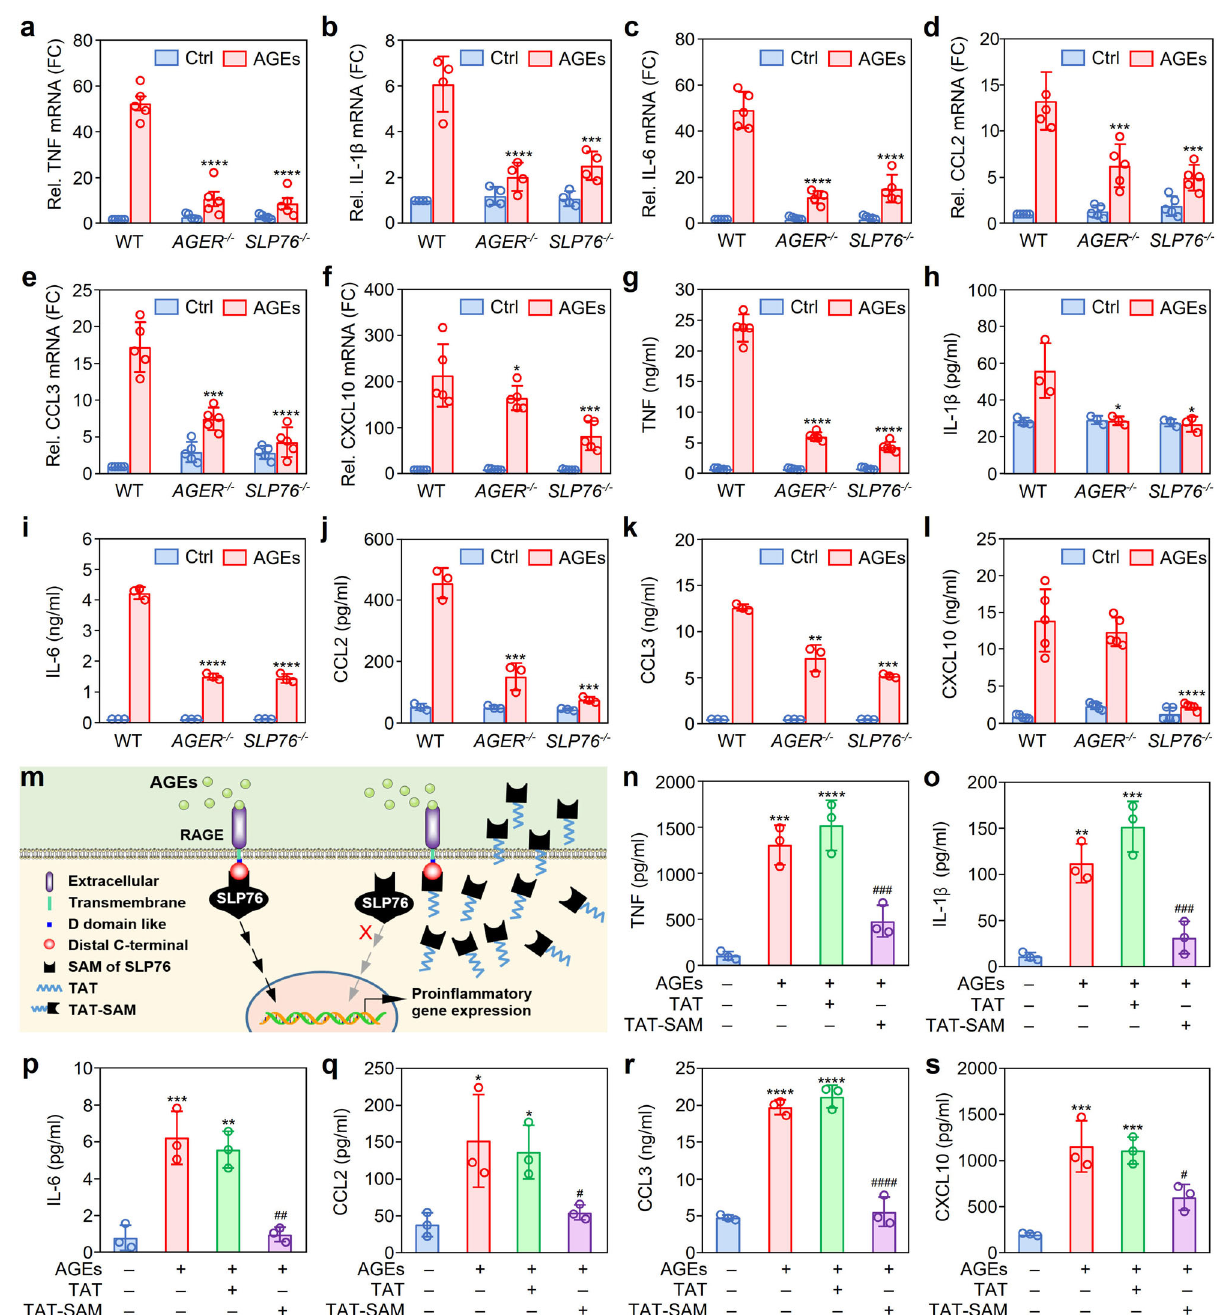
Fig. 5 Function of SLP76 in RAGE-mediated cytokine and chemokine expression. a – f Inhibitory effect of AGER and SLP76 gene de fi ciency on the mRNA expression of proin fl ammatory cytokines and chemokines. BMDMs were isolated from WT, AGER − / − , or SLP76 − / − mice and were then stimulated with or without AGEs for 3 h. The levels of mRNAs encoding cytokines and chemokines in BMDMs were quantitated by real-time PCR ( n = 5). * P < 0.05, *** P < 0.001, **** P < 0.0001 compared with the WT group (two-way ANOVA with Tukey post hoc). g – l Effect of AGER and SLP76 gene de fi ciency on cytokine and chemokine production in BMDMs. BMDMs were isolated from WT, AGER − / − , or SLP76 − / − mice and were then stimulated with or without AGEs (100 μ g/ml) for 12 h. The cytokines and chemokines in culture media were quantitated by using a multiplex LiquiChip system ( n = 3). * P < 0.05, ** P < 0.01, *** P < 0.001, **** P < 0.0001 compared with the WT group (two-way ANOVA with Tukey post hoc). m The blocking mechanism of the TAT-SAM peptide on RAGE-mediated cell signaling. After AGEs bind with the cell surface receptor RAGE, SLP76 is recruited to the cytosolic tail of RAGE as an adaptor protein to transduce signals from the extracellular environment into the cell. A peptide containing the SAM domain was delivered into cells via the TAT CPP, thus blocking the interaction between RAGE and endogenous SLP76 through competitive binding with the cytosolic tail of RAGE, which resulted in inhibition of the signaling process mediated by RAGE. n – s Effects of the synthetic TAT-SAM peptide on AGE-induced production of cytokines and chemokines. RAW264.7 cells were pretreated with the TAT-SAM peptide or with TAT alone for 1 h and were then subjected to stimulation with AGEs for 12 h. The levels of cytokines and chemokines in culture media were quantitated by using a multiplex LiquiChip system ( n = 3). * P < 0.05, ** P < 0.01, *** P < 0.001, **** P < 0.0001 compared with the untreated group; # P < 0.05, ## P < 0.01, ### P < 0.001, #### P < 0.0001 compared with the TAT group (one-way ANOVA with Tukey post hoc). Data are presented as mean ± SD in ( a – i ) and ( n – s ). Source data are provided as a Source data fi le. NATURE COMMUNICATIONS| (2021) 12:308 |https://doi.org/10.1038/s41467-020-20577-3|www.nature.com/naturecommunications